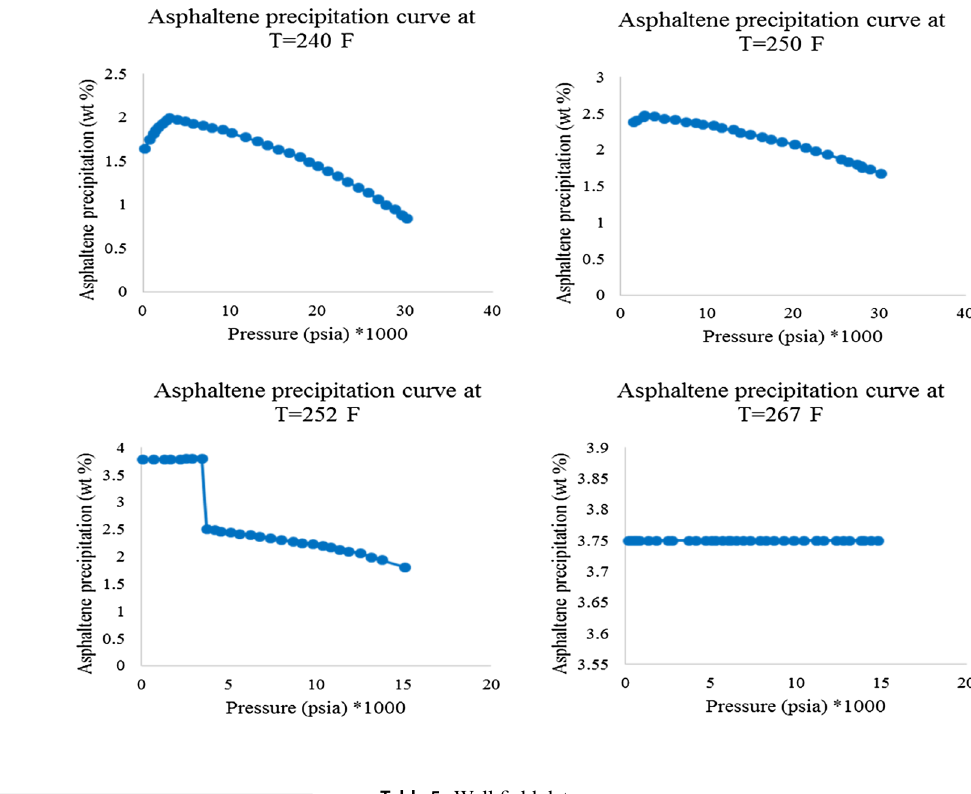
Table 5 Well field data